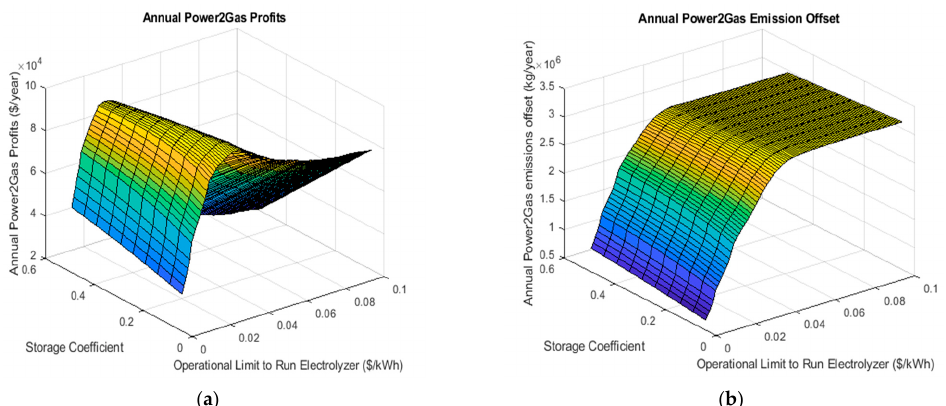
Figure 4. Surface plots illustrating the effect of changes in the storage coefficient and the operational limit on the electrolyzer on the annual power-to-gas profits ( a ) and emissions offsets ( b ).